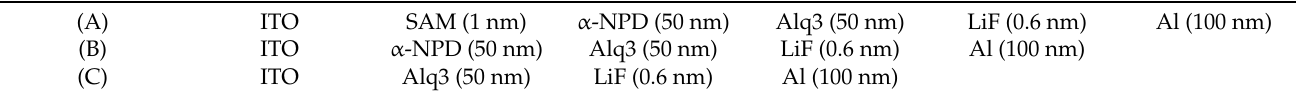
Table 1. OLED layer